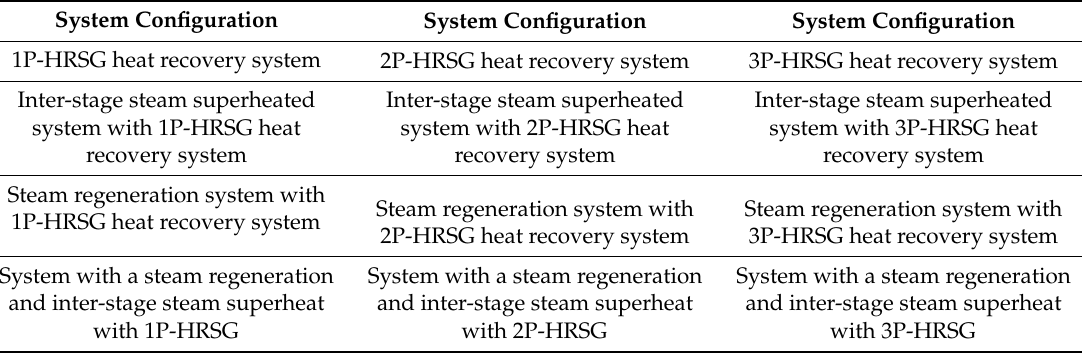
Table 2. The lists of analysed